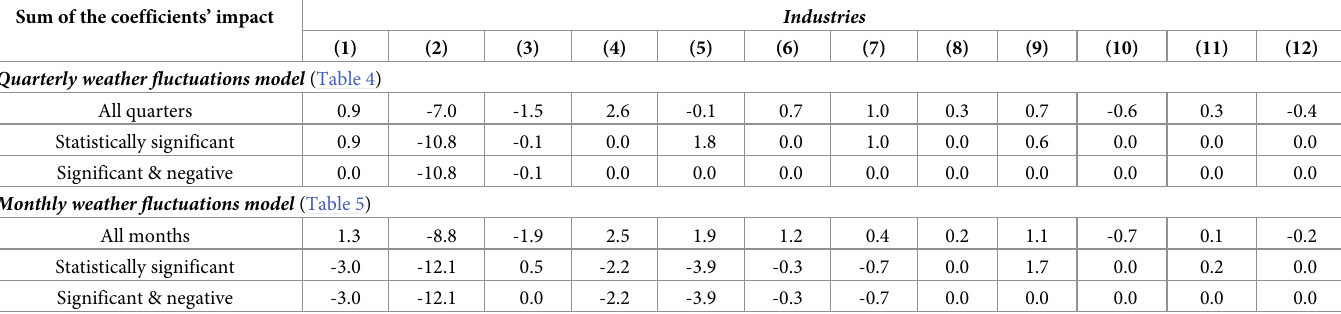
Table 6. Total impact on the industry GDP growth rate (in %) of the estimated models for a one degree Celsius temperature increase throughout the year. Sum of the coefficients’